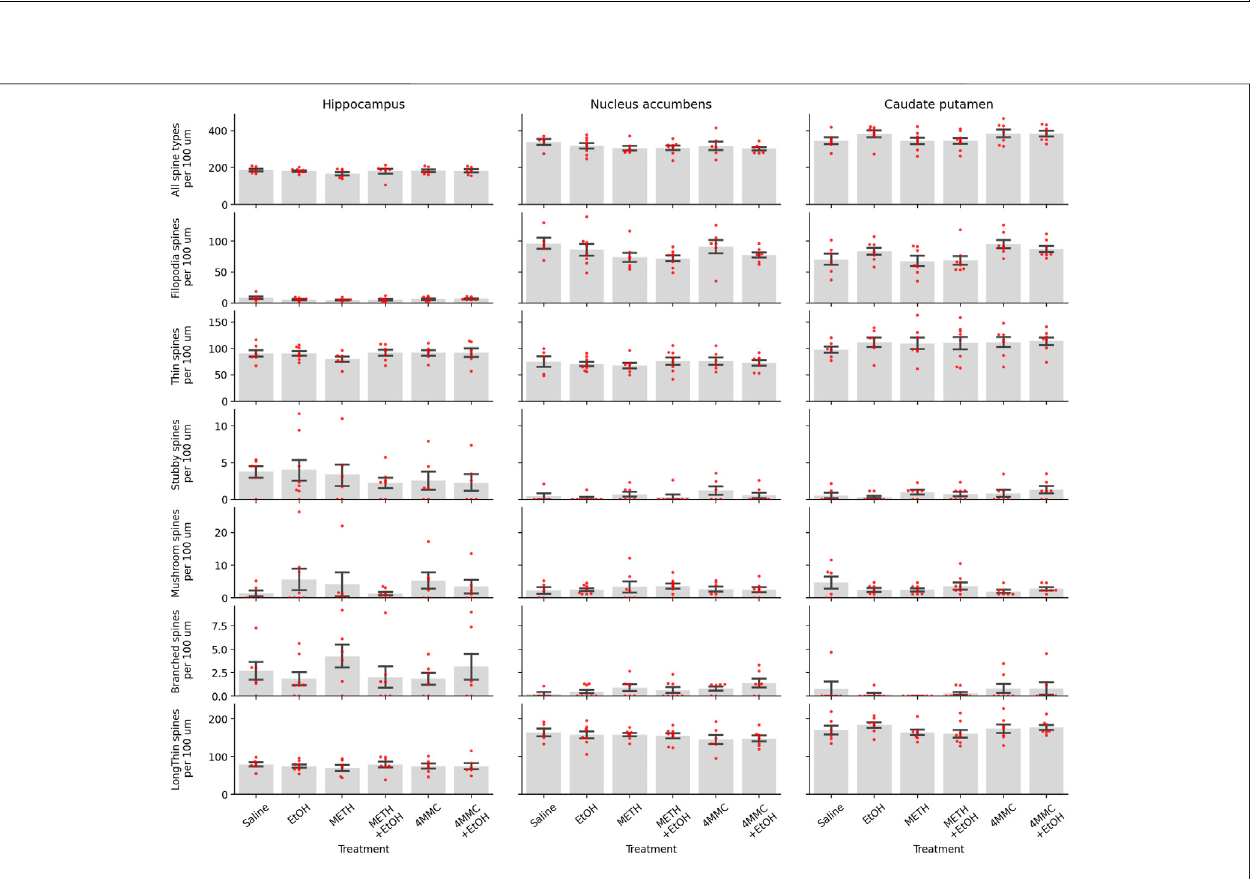
Frontiers in Pharmacology |